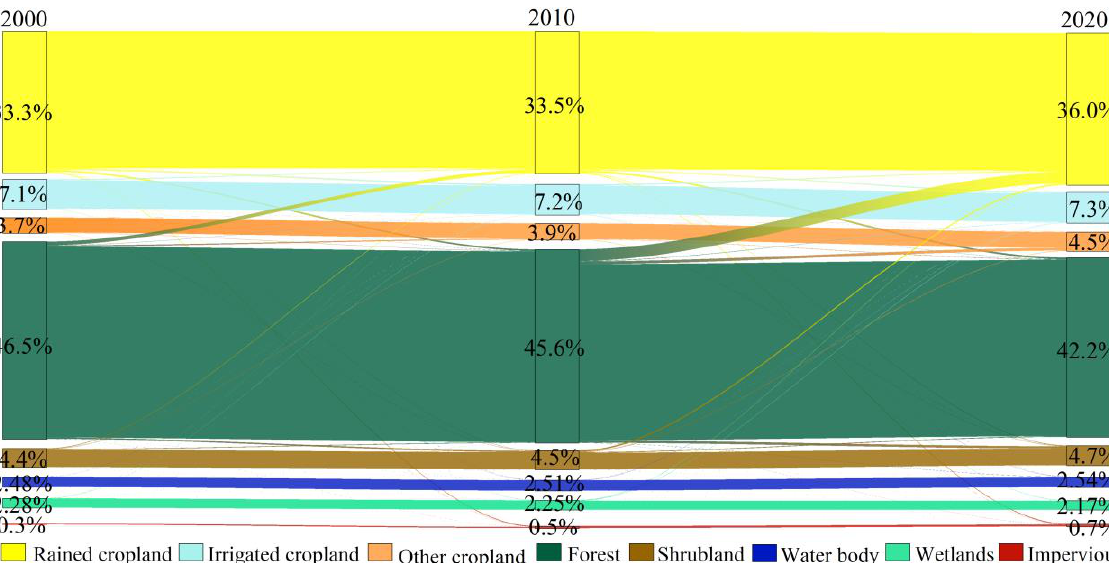
Figure 3. The spatial distribution map of the integrated dynamic degree of LUC in Cambodia from 2000 to 2020.